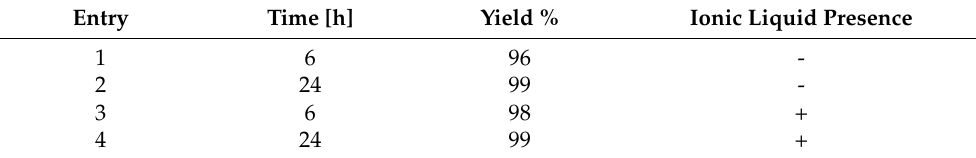
Figure 8. The process of DKR with and without the addition of an IL. Table 3. DKR results.